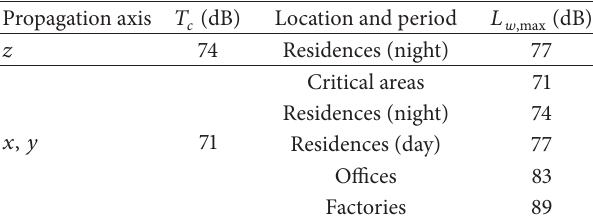
Table 2: Critical limits for comfort analysis according to UNI 9614 [14].